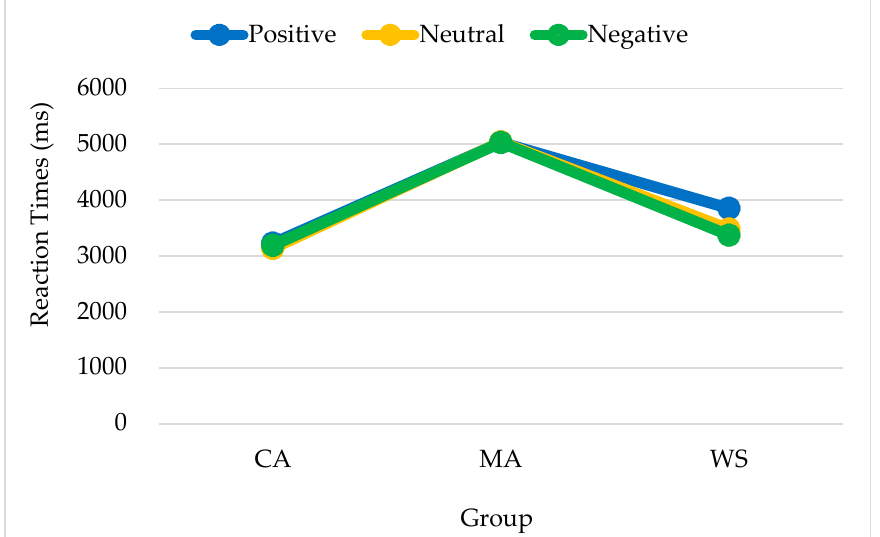
Figure 4. Reaction times of the responses to positive primes by emotion target type and group. Note. CA, chronological age-matched controls; MA, mental age-matched controls; WS, participants with Williams syndrome.